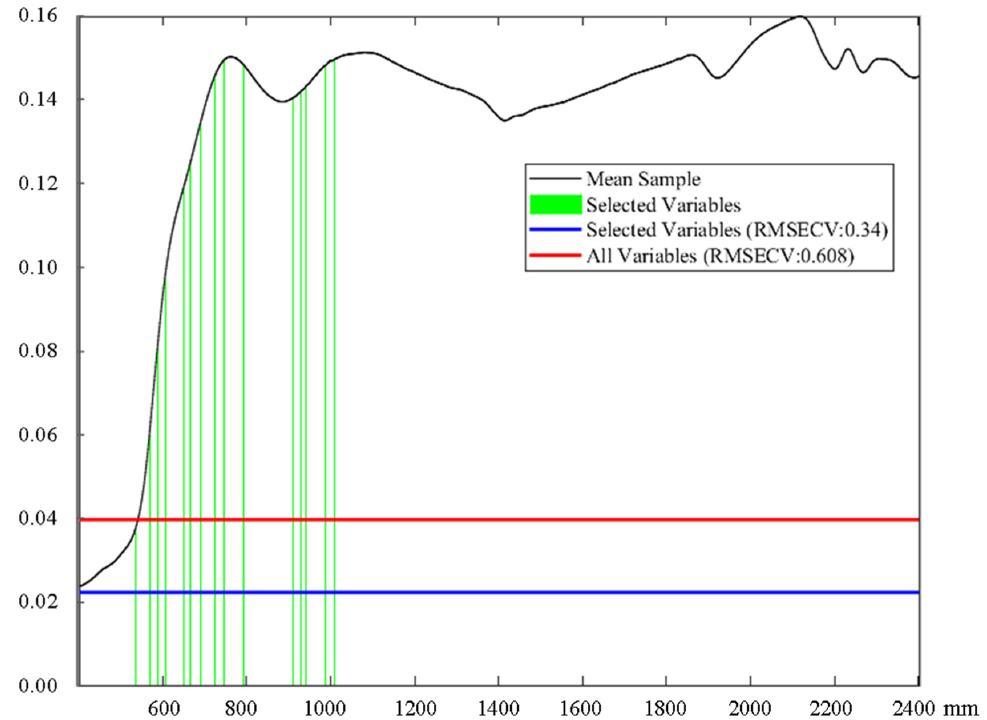
Figure 5. Example of selection of iPLS variables for CEC in the second soil assessment. The Y -axis unit is in reflectance factor for the mean sample, and for RMSECV is in cmolc dm − 3 . The wavelengths selected by the iPLS algorithm for each soil characteristic are shown in Figure 6. Note that for each chemical characteristic, different wavelengths were selected in the four assessments due to the variability in these characteristics (Table 2) over the assessment period. For characteristics with lower variability, such as CEC, the selected wavelengths were more similar among the soil assessments. Furthermore, for the Ca 2+ and Mg 2+ content, the selected wavelengths of close to 1.690 and 2.300 nm are related to the applied dolomitic limestone (CaMg (CO 3 ) 2 ) [65].